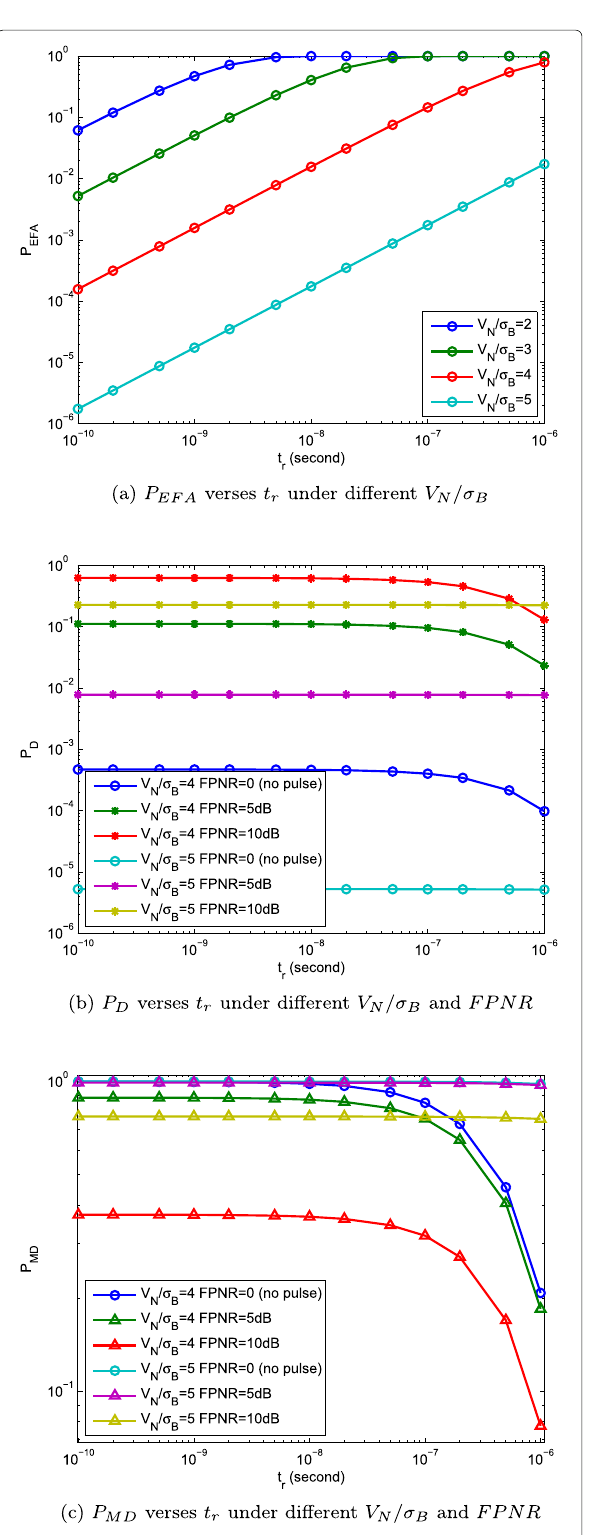
Fig. 5 Relation between P EFA , P D and P MD as a function of the true FP arrival time t r , and the parameters V N /σ B and FPNR as deduced from